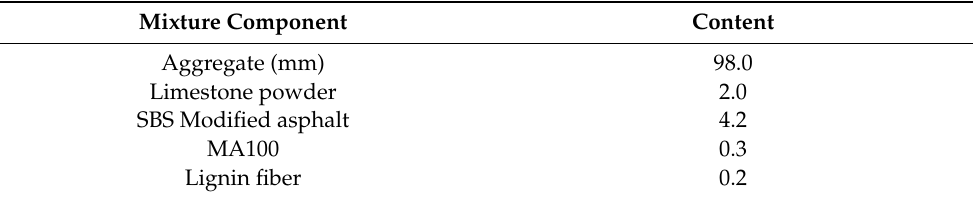
Table 2. Material composition and quality of PA mixture.